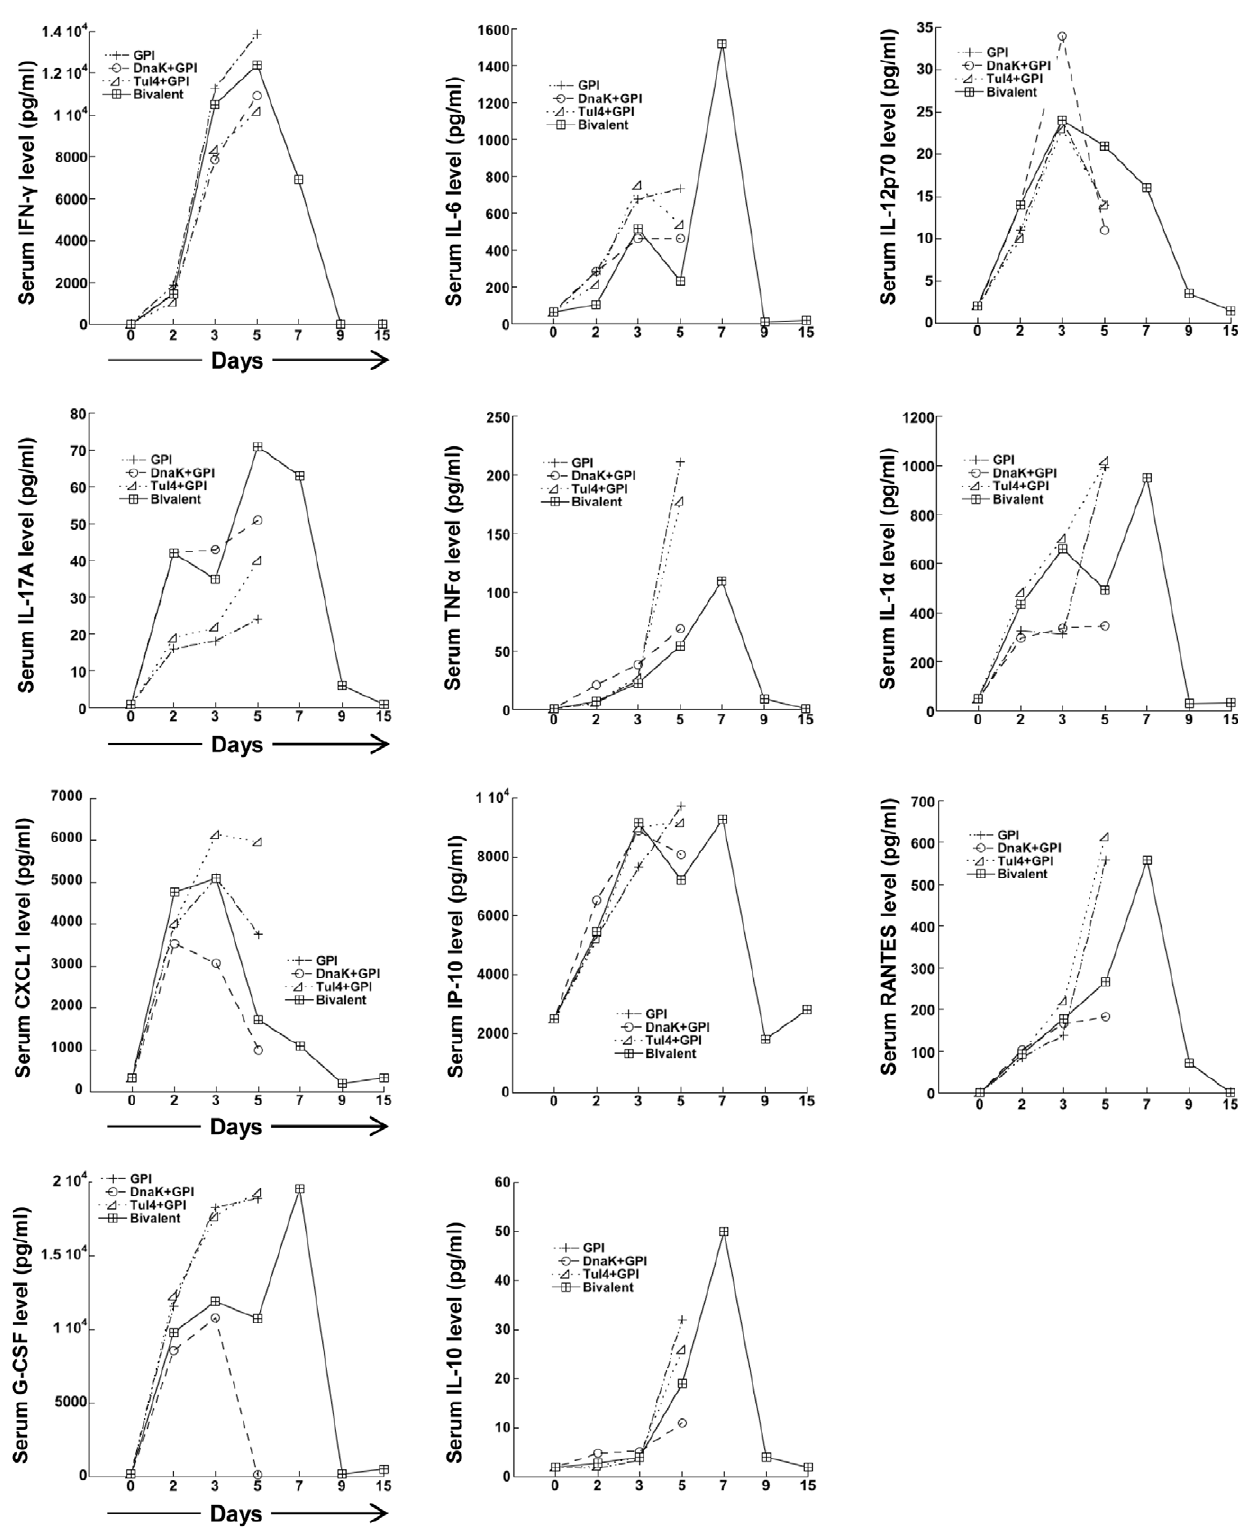
Figure 8. Serum cytokine/chemokine responses in mice immunized with the subunit vaccine and infected with FT LVS via the respiratory route. Levels of various cytokines/chemokines in sera of GPI control mice or of mice immunized with DnaK + GPI, Tul4 + GPI, or DnaK + Tul4 + GPI and then challenged with FT LVS (1.5 6 10 6 CFU) via the i.n. route were assessed using a mouse multiplex kit. Serum samples were collected on days 0, 2 and 3, and then every other day until the mice succumbed to infection or until day 15 from surviving mice. There were 5 mice per group and the values are expressed as the mean.